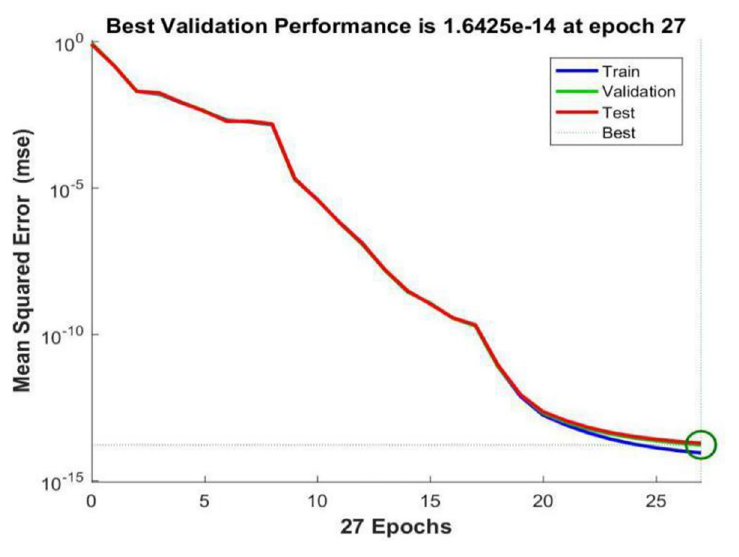
Fig 6. Trainlm performance graph.